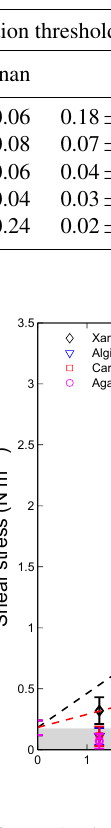
Figure 4. The threshold for erosion of 110µm sandy substrate with different contents for four extracted EPSs as measured with the CSM erosion device. Best-fit curves were fitted using linear mod- els for xanthan gum (shear stress threshold of 0.28; EPS content of + 0.18) and carrageenan (shear stress threshold of 0.11; EPS con- tent of + 0.18). Error bars are standard deviations from n = 5 repeat